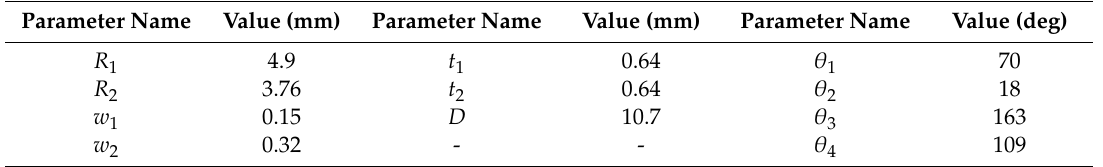
Table 2. Antenna parameters.